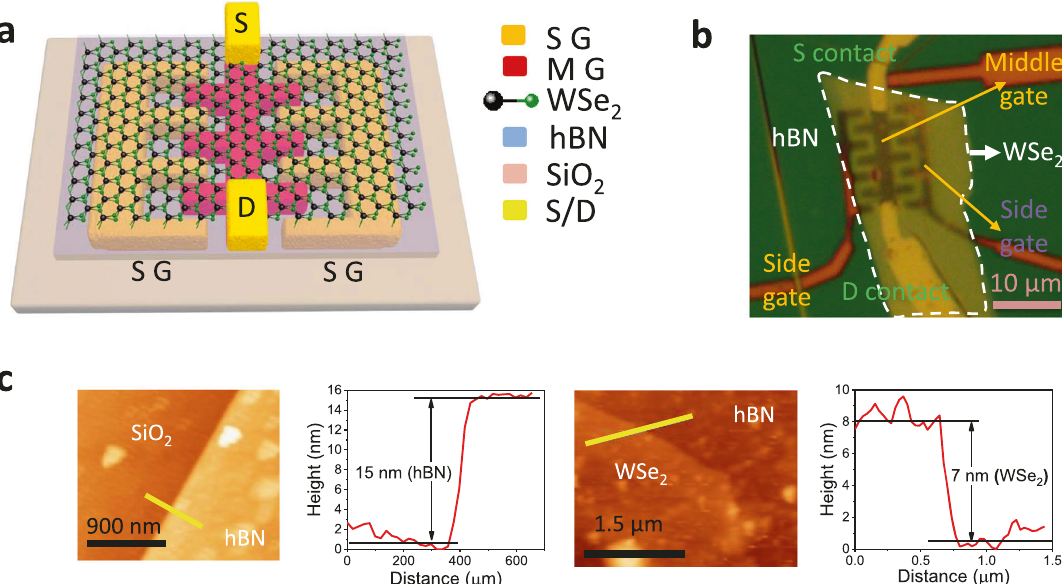
Fig. 1 Device architecture and material thicknesses. a 3D schematic of the WSe 2 phototransistor with middle (MG) and side gates (SG). The transparent blue layer is hBN on top of metal back gates on SiO 2 /Si and underneath WSe 2 (channel material). The top layer in the green ( ‘ Se ’ atom) and black ( ‘ W ’ atom) ball-stick structure represents WSe 2 . b Optical microscope image of the device with MG and SGs de fi ned at the bottom and S/D contacts on the top. c AFM scans indicate that the WSe 2 channel is 7 nm thick and the hBN gate dielectric is 15 nm